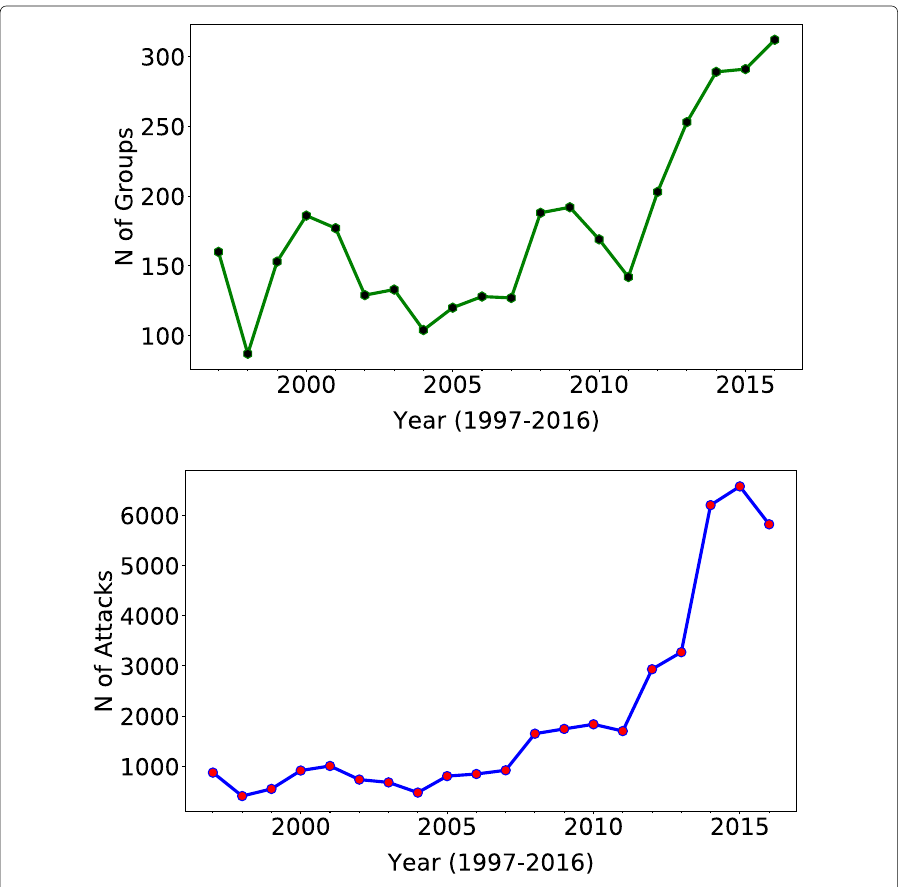
Fig. 7 Number of Active Groups and Terror Attacks per Year